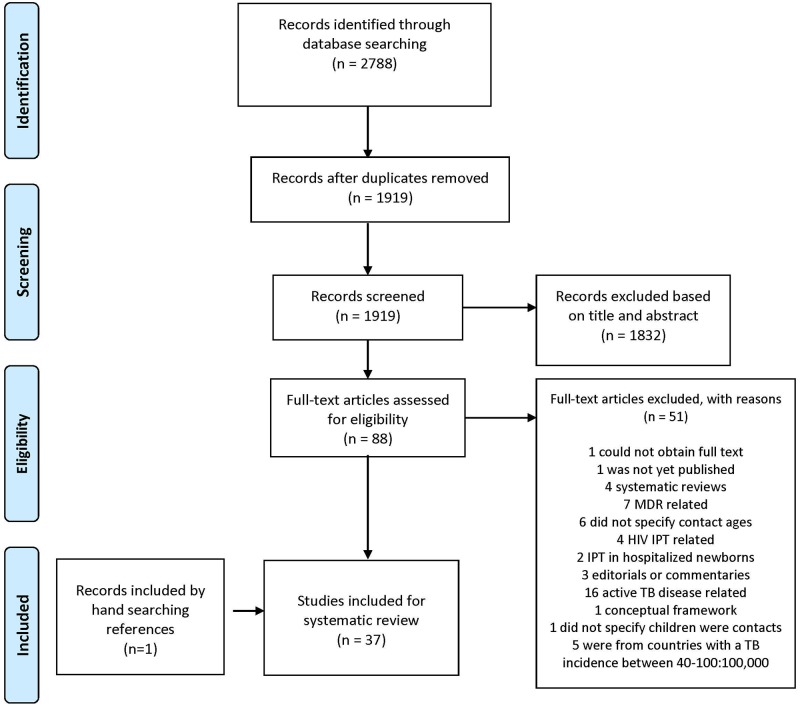
Study selection.